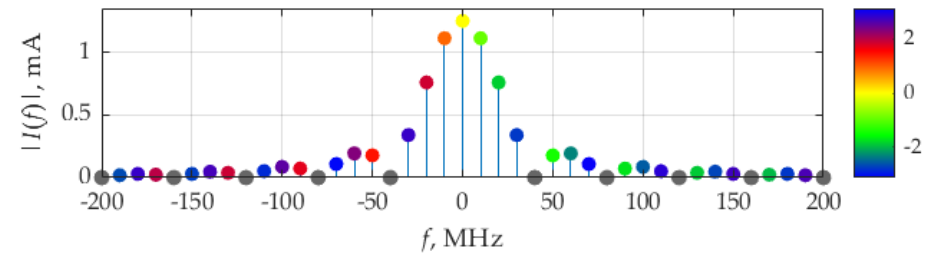
Figure 9. The current spectrum for the case of pulse train current.